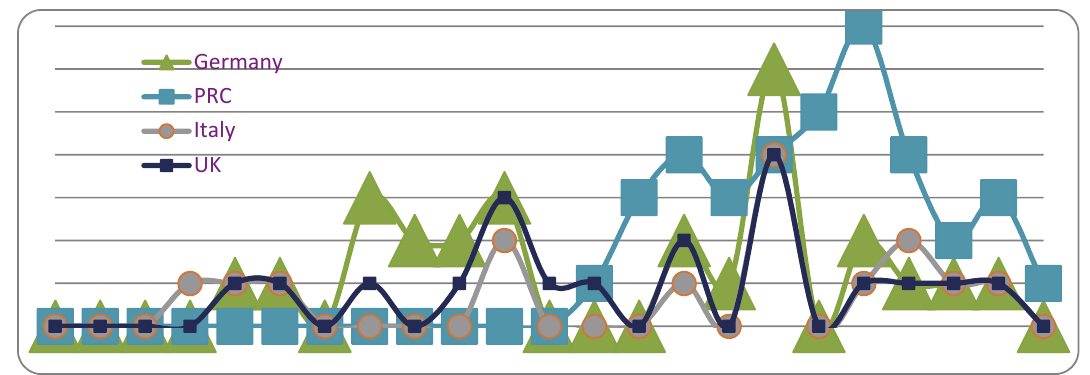
Fig. 4. Number of Life Insurance Efficiency Studies When Taking Multiple Nation Studies into Account Regarding Germany, the PRC, Italy and the UK